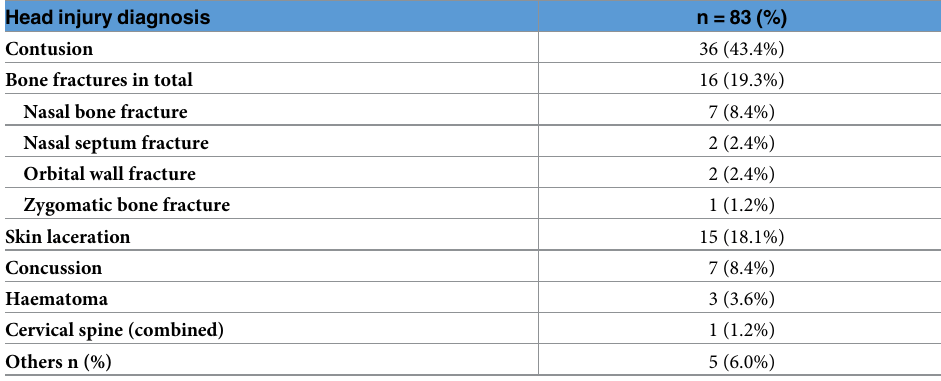
Table 3. Diagnoses of head injuries registered with the accident insurance.